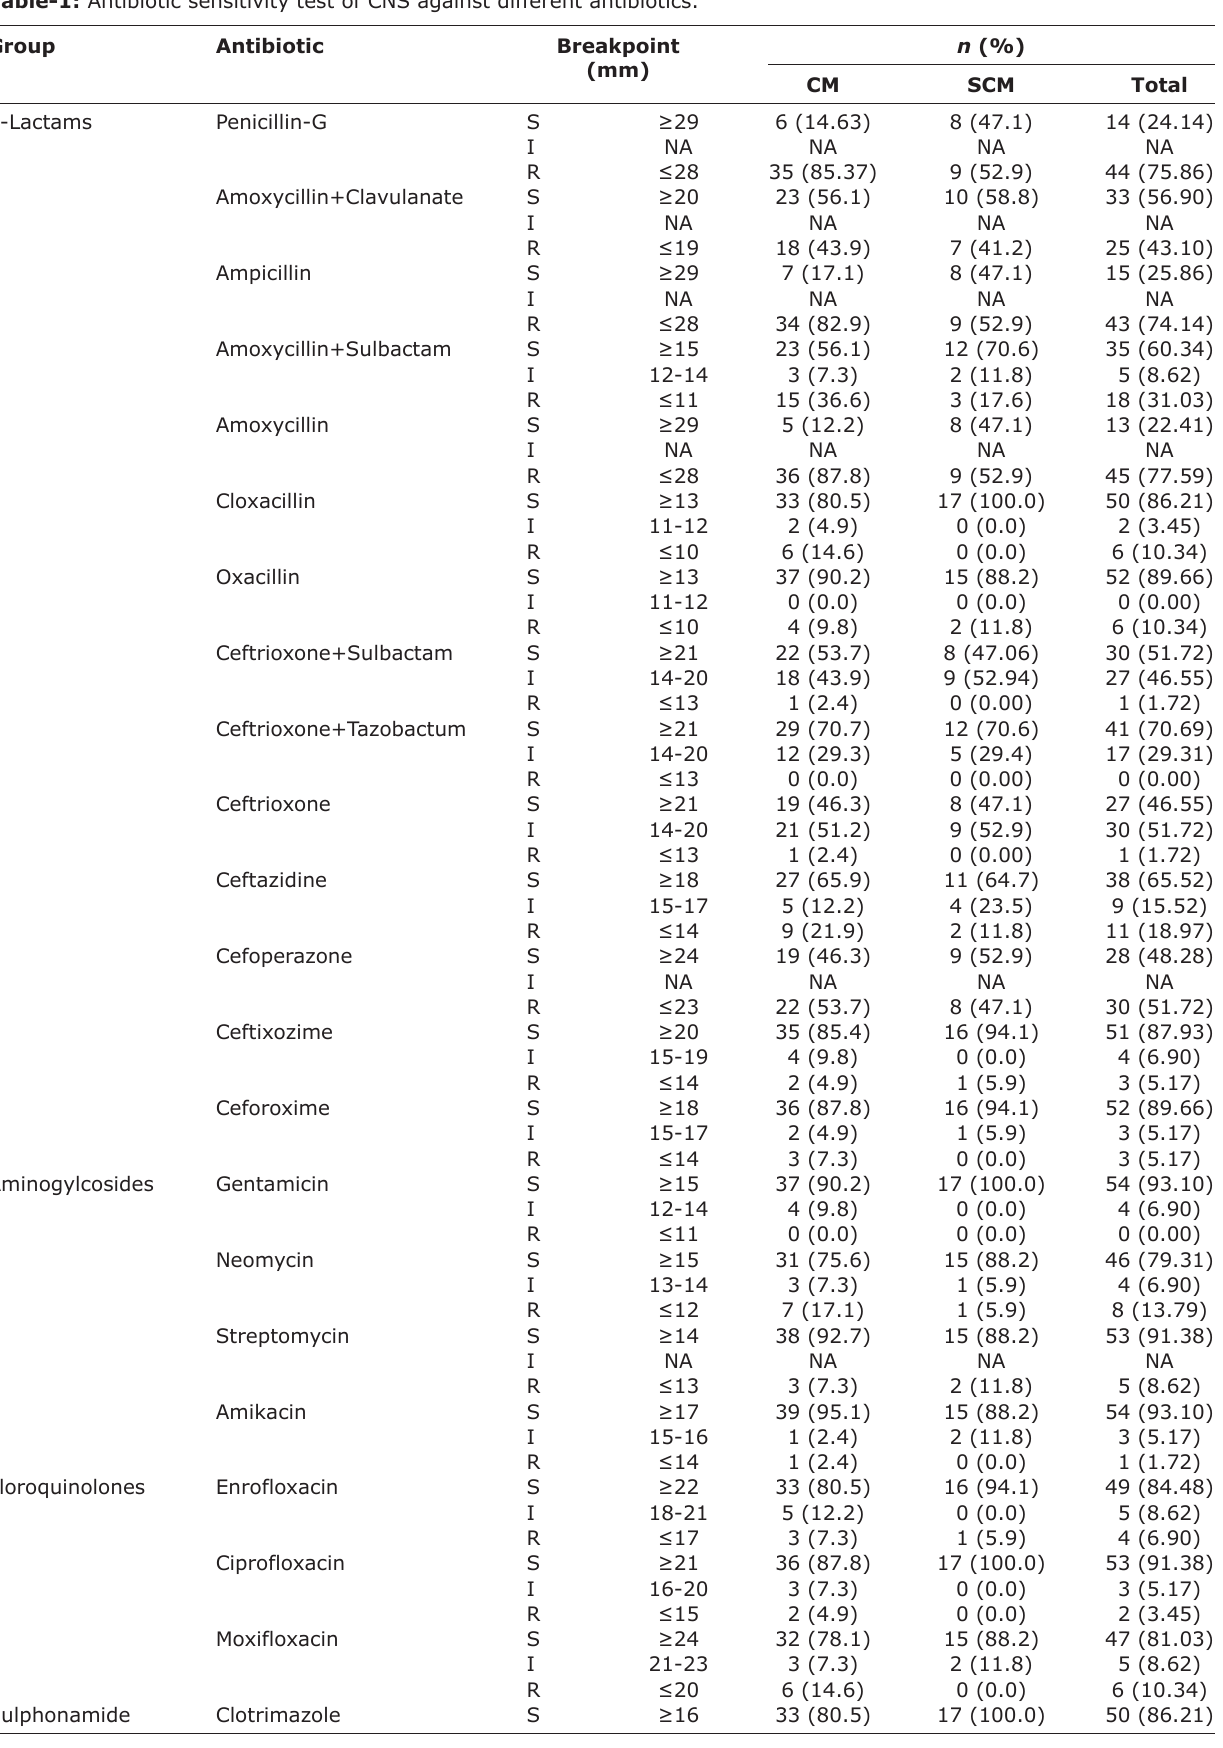
Table-1: Antibiotic sensitivity test of CNS against different antibiotics. Group